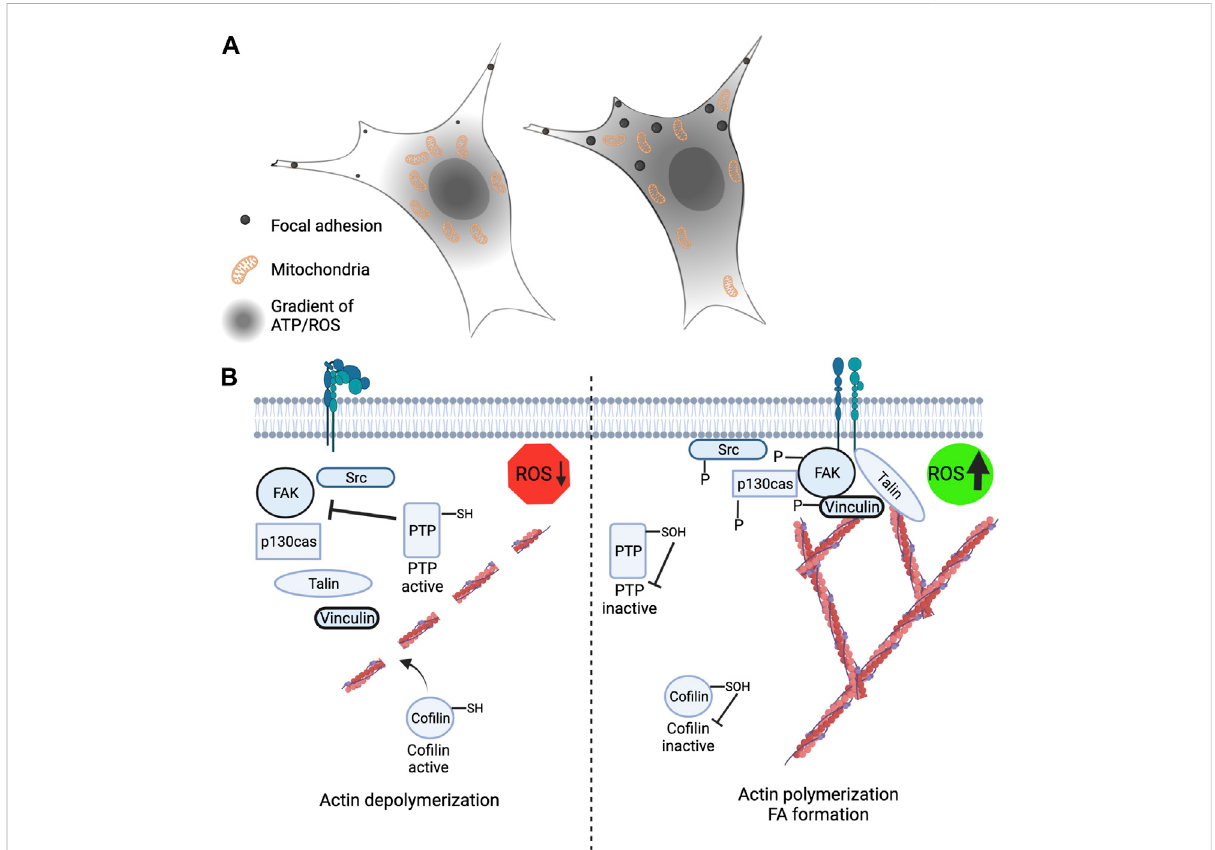
FIGURE 3 Leading edge mitochondria and redox signaling contribute to cytoskeleton rearrangement and cell migration. (A) (Left) Restriction of mitochondria to the perinuclear space leads to loss of peripheral ATP and ROS levels and correlates with smaller and less stable focal adhesions. (Right) Mitochondria that arestrategically localized and recruited to thecellperipheryhave an extended gradient ofATP and mROSand iscorrelated withlargerandmorestablefocaladhesions. (B) (Left)LowROSlevelsatthecellperipherypromotesactinseveringthroughco fi linactivationand increased protein tyrosine phosphatase activity leading to reduced phosphorylation of FAK, p130cas, vinculin and Src. (Right) Elevated ROS levels at the cell periphery promotes actin polymerization and branching through redox-dependent inactivation of co fi lin. Inactivation of PTP ’ s by ROS promotes increased FAK, p130cas, vinculin and Src